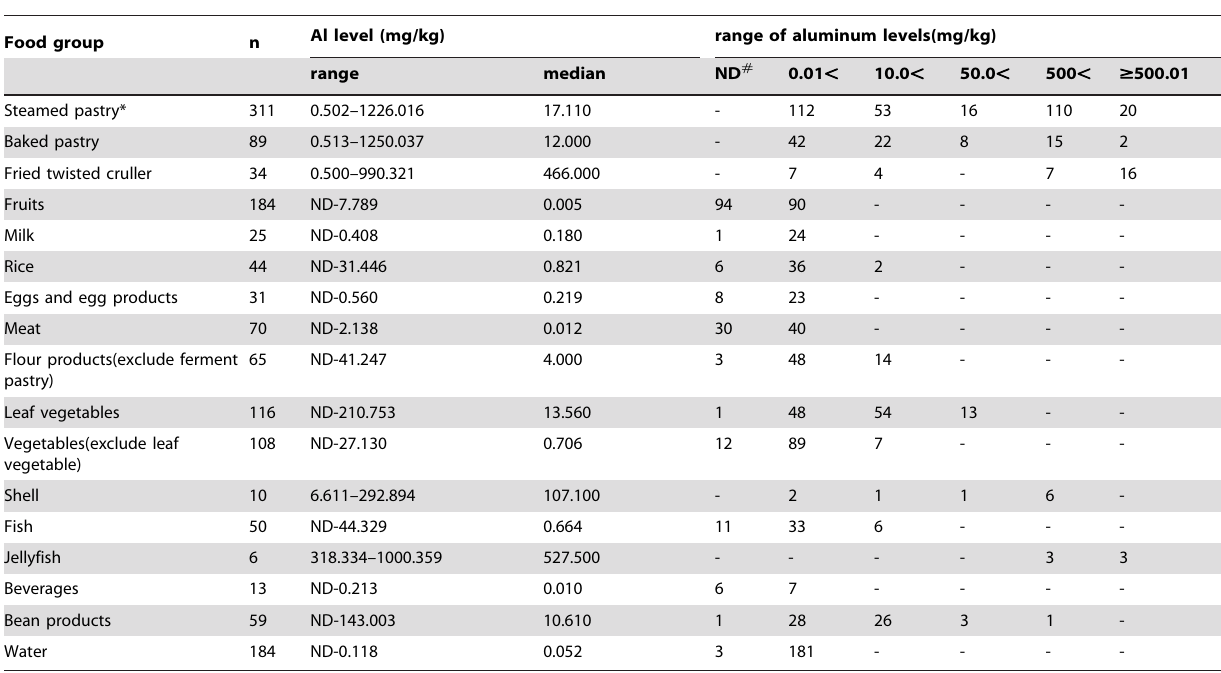
Table 3. Concentrations of Aluminum in the 17 food groups in Shenzhen, China.